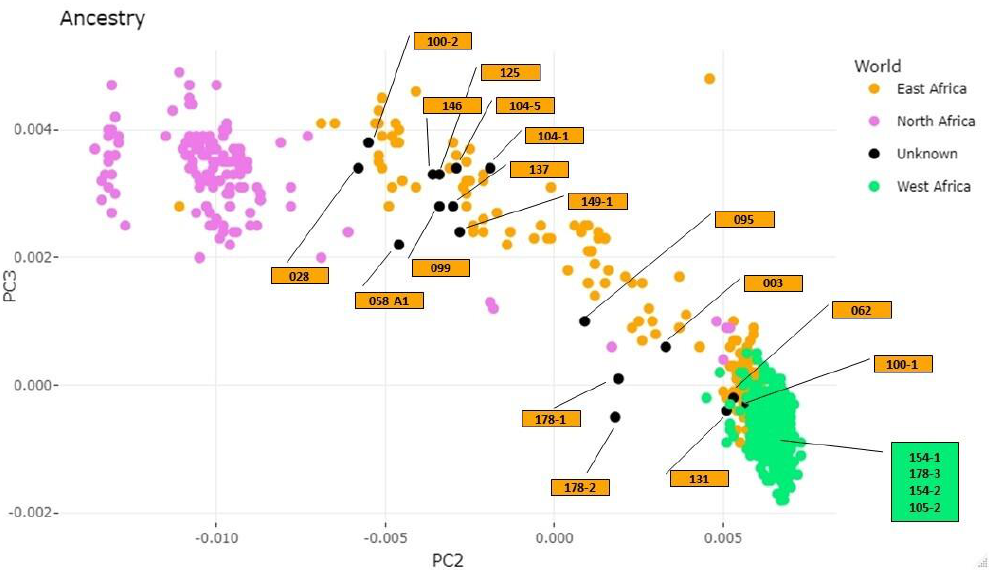
Figure 3. Individuals from the African database were subdivided into different geographical areas and each area is represented by a color. Unknown individuals are in black, and each black dot has been labeled with the specimen name. Score plots PC1, PC2, and PC3. Table 3. ID sample, number of reads mapped on the Y chromosome, number of SNPs used for the Yleaf analysis of each individual, and QC score, i.e., an overall quality score of the predicted haplogroup. The haplogroups that were assigned manually are shown in red.